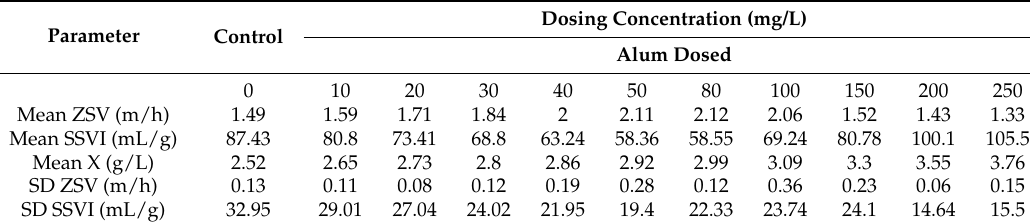
Table 1. Mean and standard deviation data of zone settling velocity (ZSV) and stirred specific volume